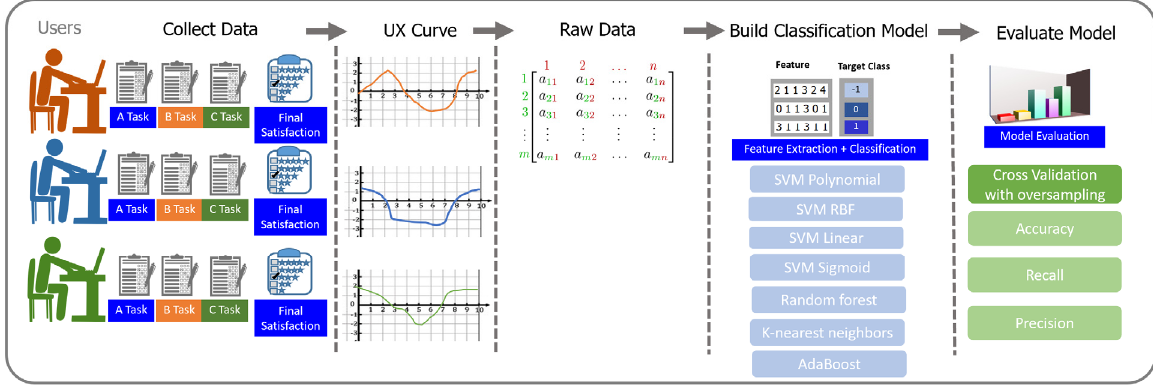
Figure 6. Workflow of our proposed evaluation process.